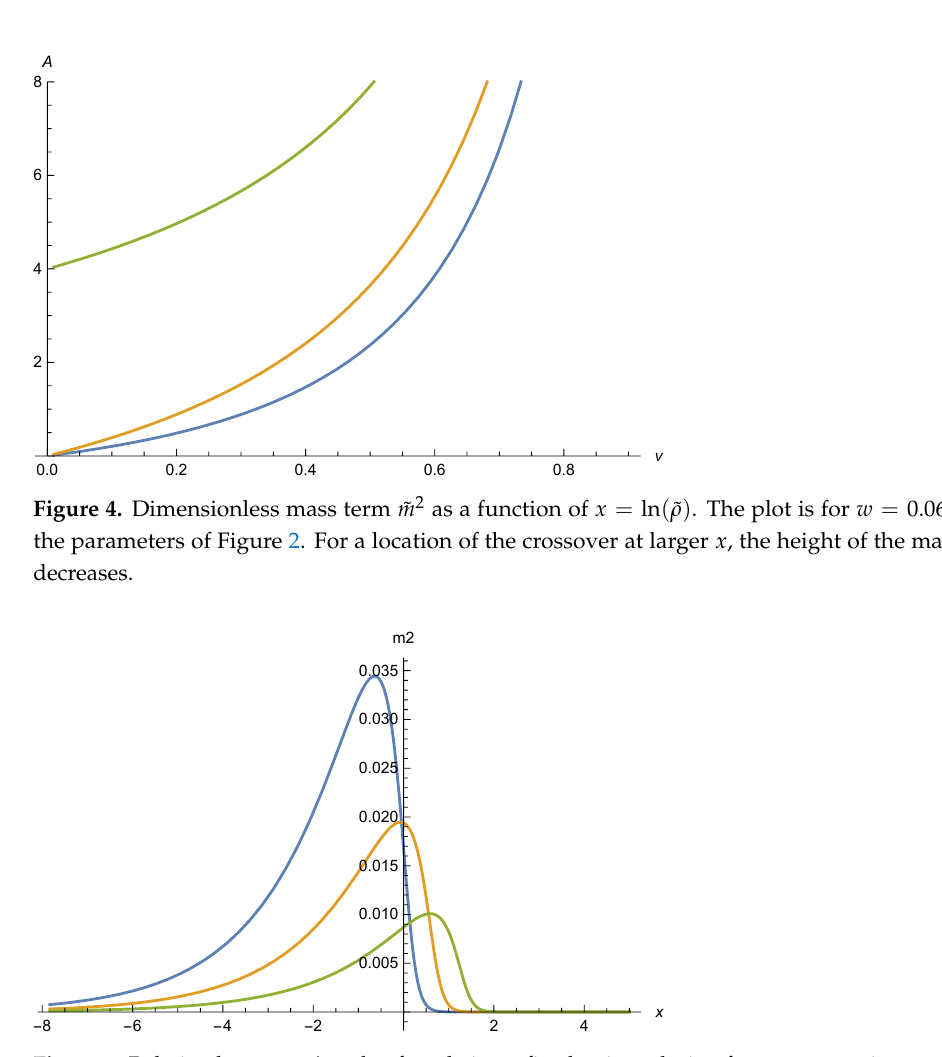
Figure 5. Relation between A and v , for v being a fixed point solution for an appropriate w as given by the relation (32). We show three values of N = 12 (lower curve), N = 4 (middle curve), and N = − 4 (upper